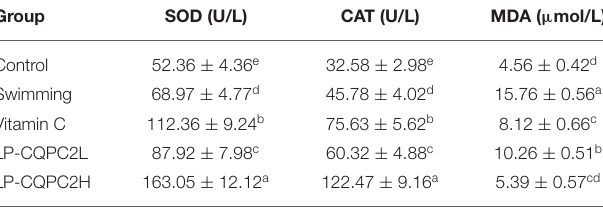
TABLE 4 | Serum SOD, CAT, and MDA levels of mouse in each